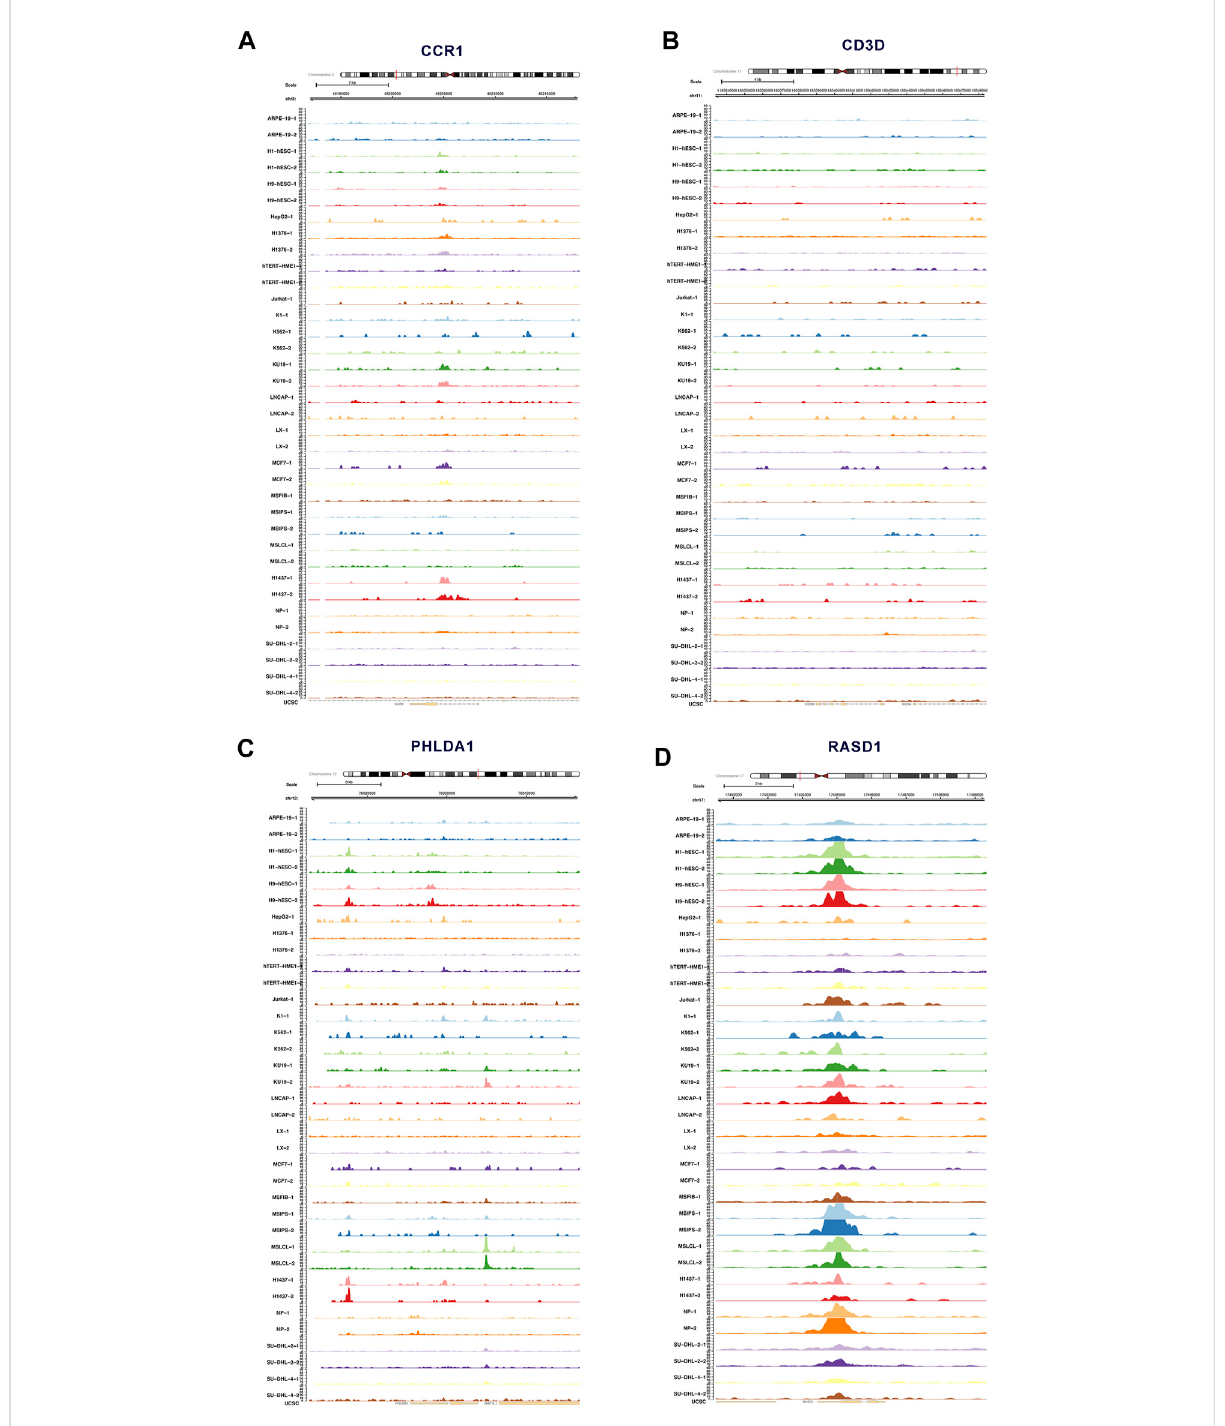
FIGURE 7 ATAC-seq analysis of key DEeRNAs. (A) The accessible chromatin sites of CCR1 analyzed by ATAC-seq. (B) The accessible chromatin sites of CD3D analyzed by ATAC-seq. (C) The accessible chromatin sites of PHLDA1 analyzed by ATAC-seq. (D) The accessible chromatin sites of RASD1 analyzed by